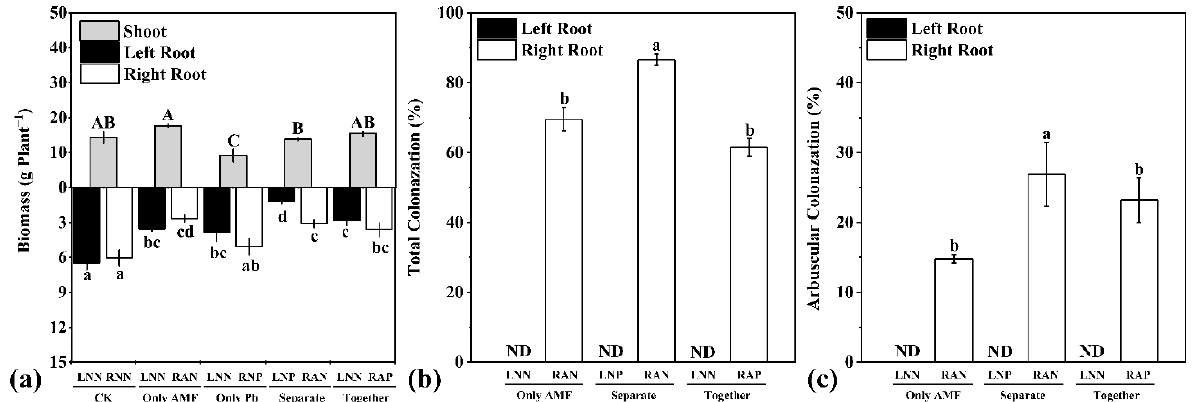
Figure 2. Effects of Pb and R. irregularis inoculation on fresh weight of shoots and roots ( a ), total colonization ( b ), and arbuscular colonization ( c ) in M. truncatula . The data are shown as means ± standard error ( n = 3). Different uppercase and lowercase letters above the columns indicate a significant difference among the means by LSD test ( p < 0.05), respectively. ND = not detected. The abbreviations are consistent with Figure 1.